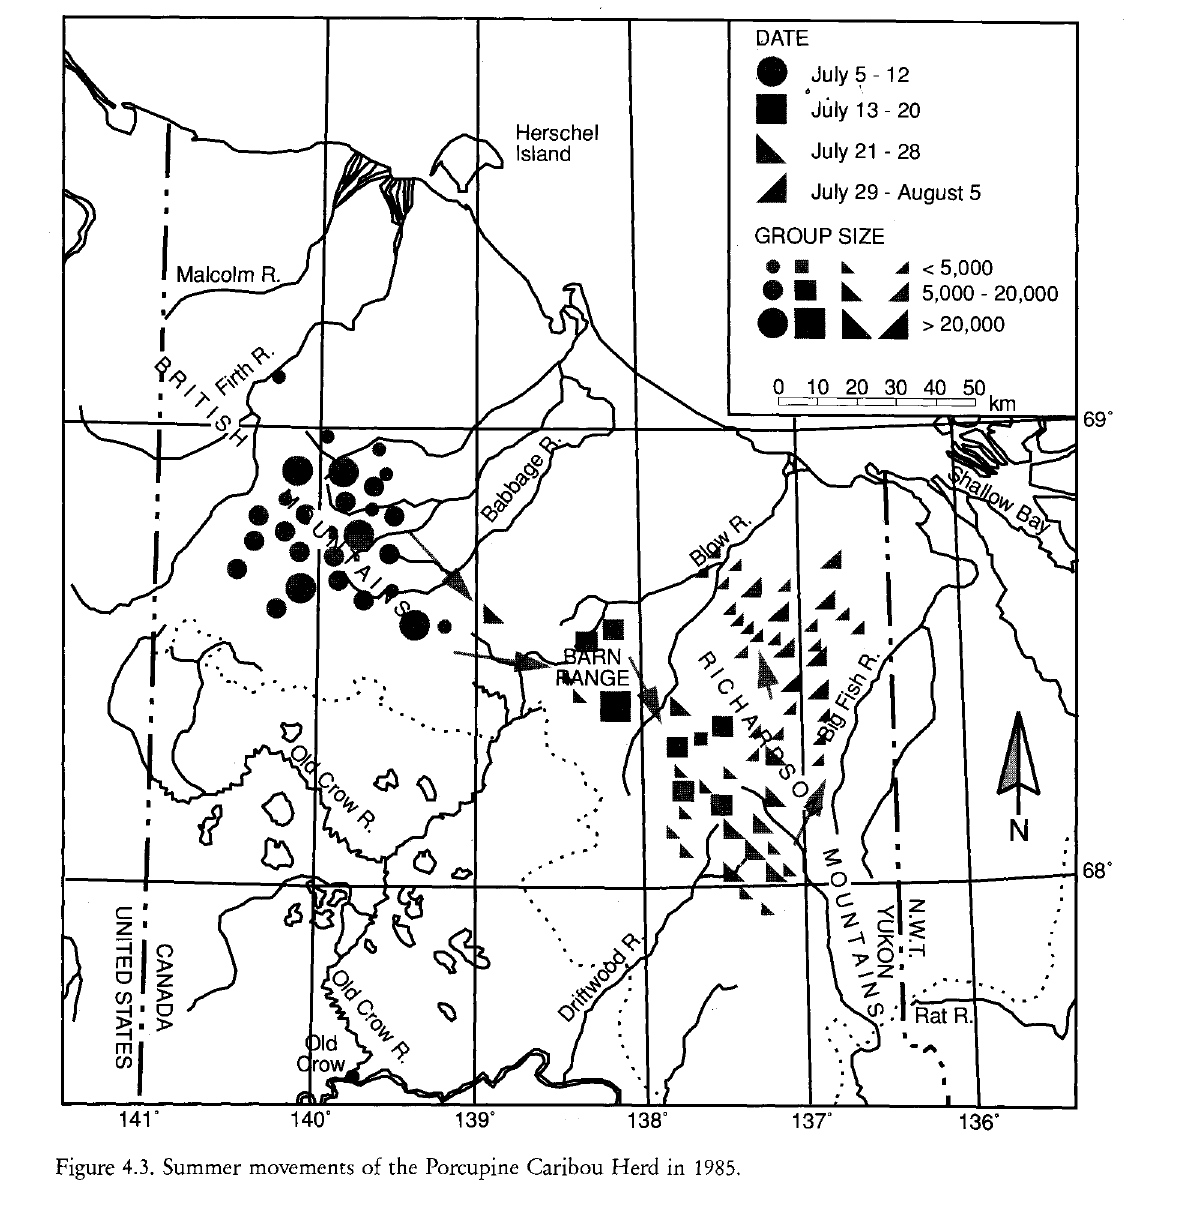
Figure 4.3. Summer movements of the Porcupine Caribou Herd in